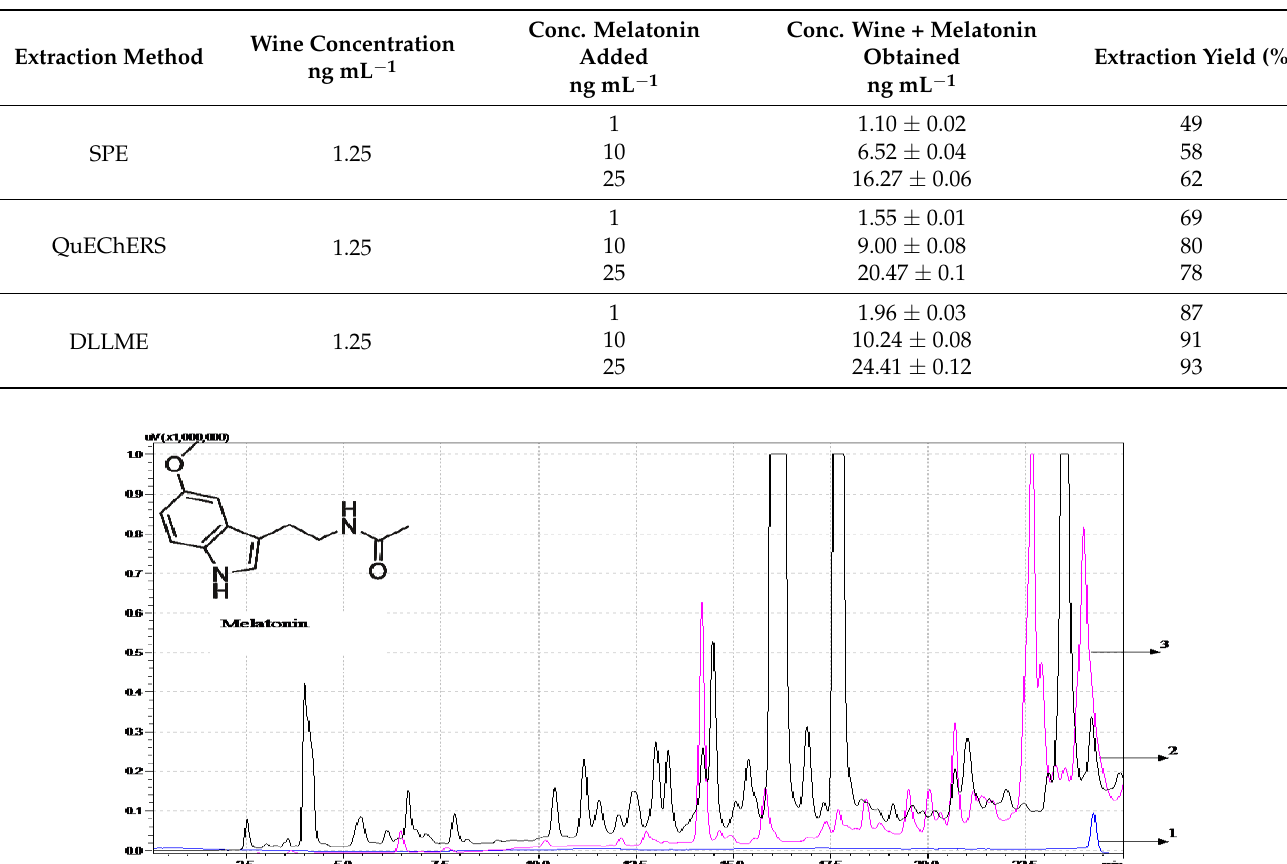
Figure 1. Chromatograms obtained for melatonin—standard and wine samples (blue—standard, black—wine sample, pink—wine sample after DLLME, 1,2,3—melatonin peaks) by HPLC-FL (λ ex = 285 nm, λ em = 340 nm).